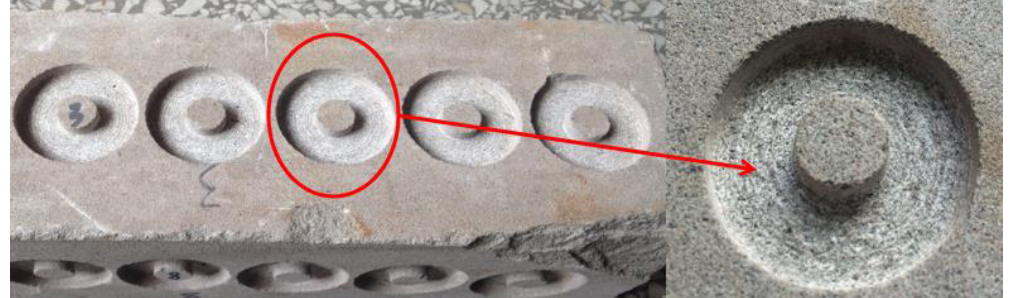
Figure 6. The granite micro bottom hole.